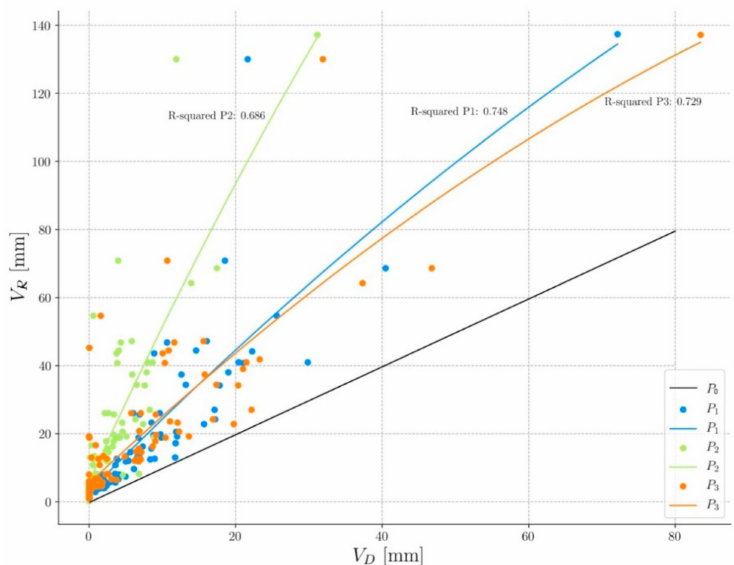
Figure 5. Relationship between drainage volume (V D ) and rainfall volume (V R